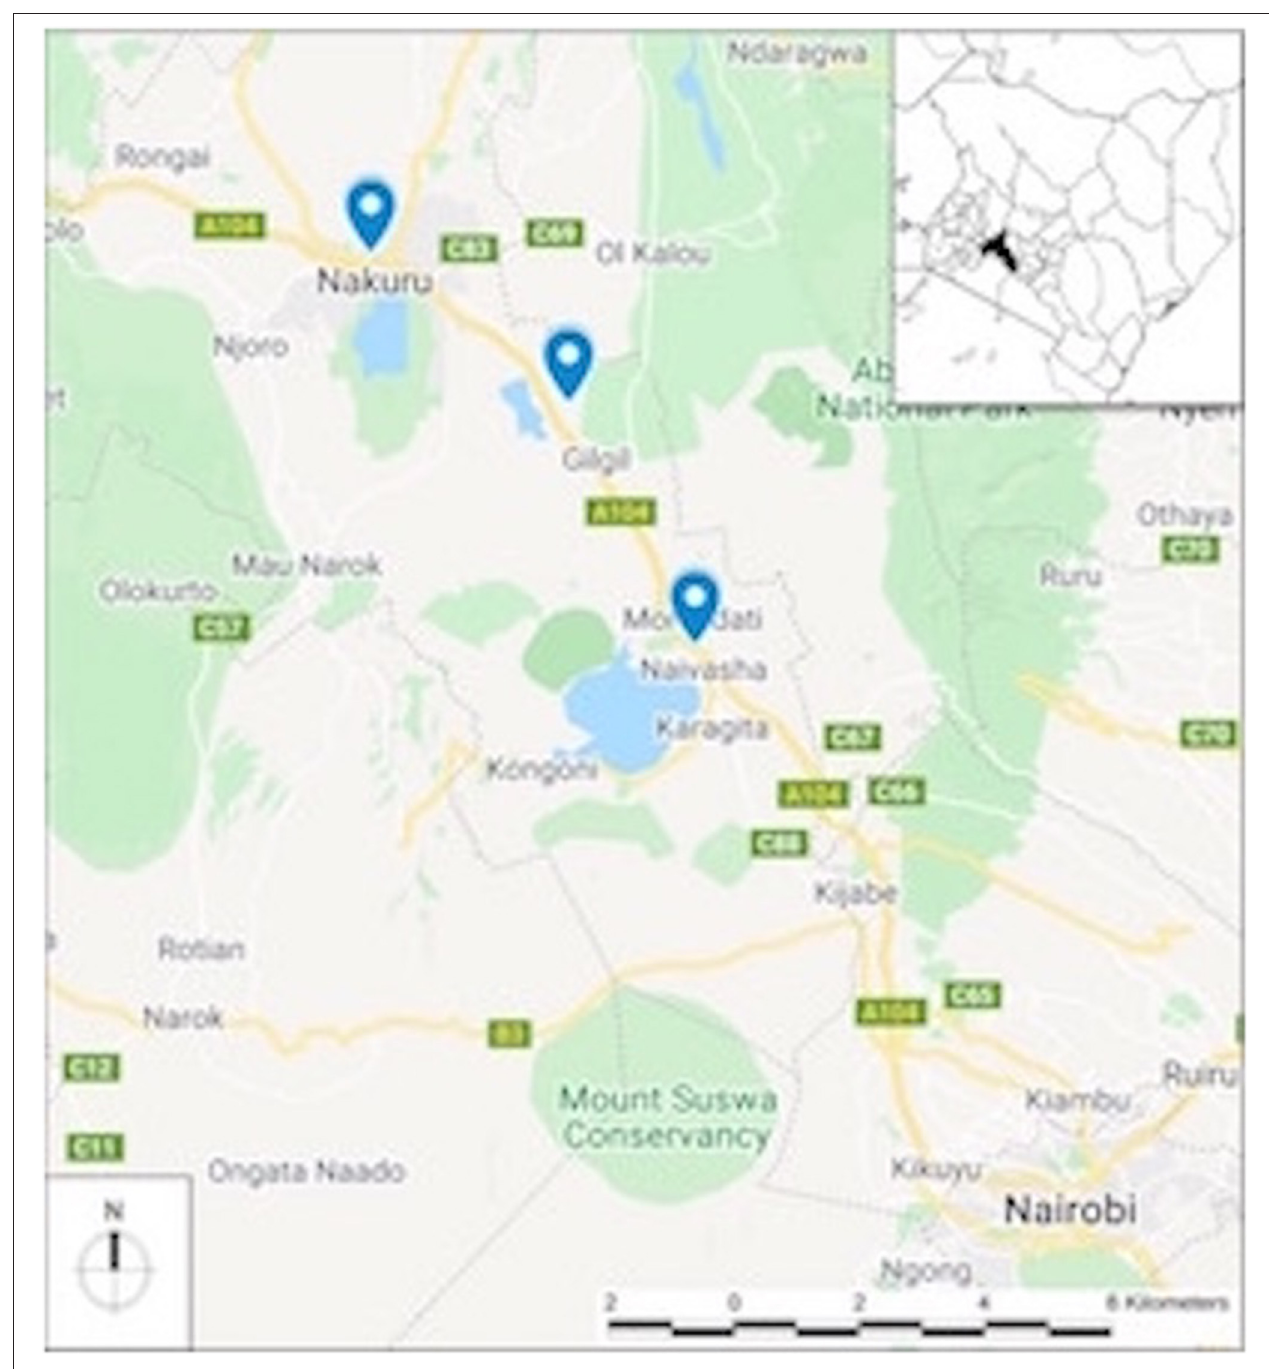
FIGURE 1 | Geolocation of the three study